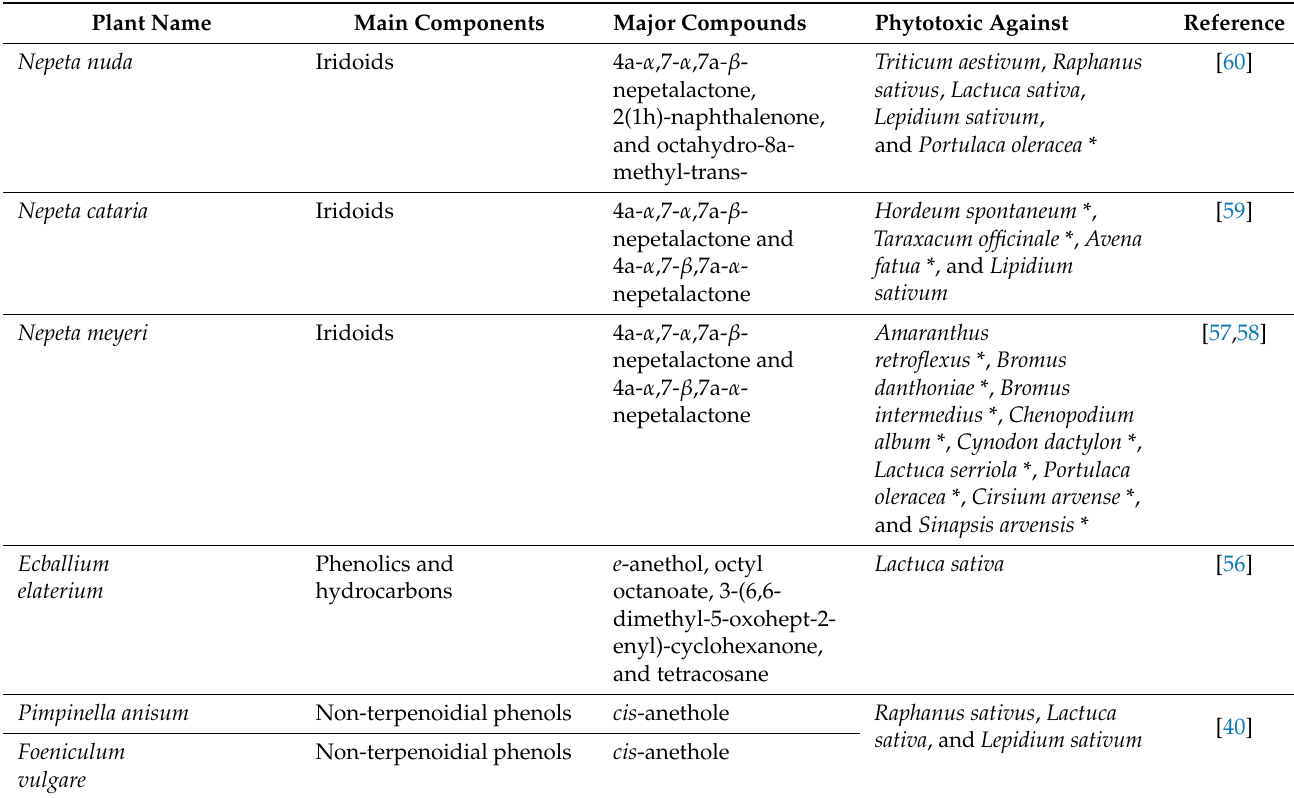
Table 3. Nonterpenoidial-rich EOs derived from plants and with significant phytotoxic activity. Plant